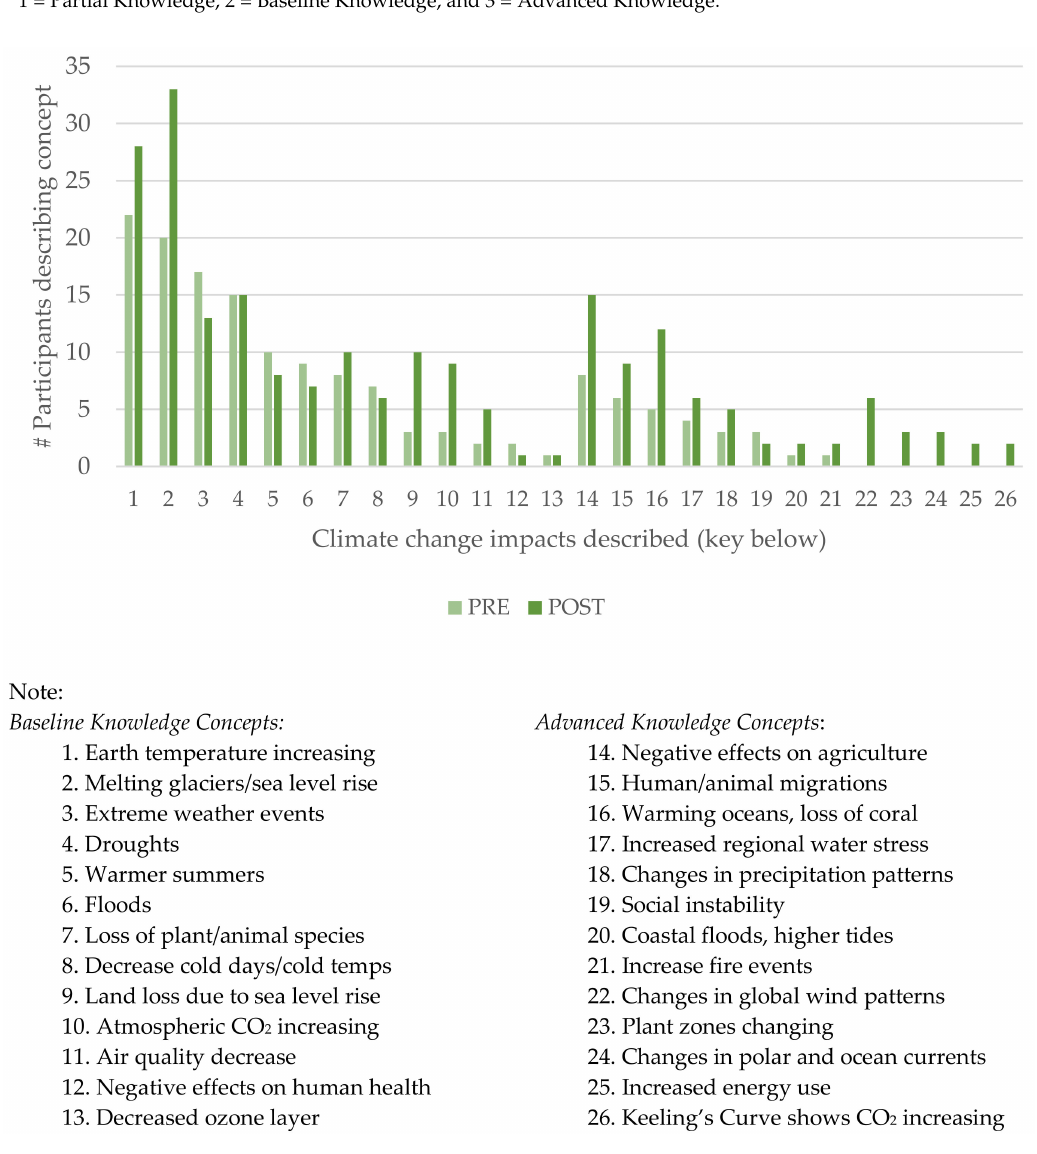
Figure 3. Described knowledge concepts of climate change